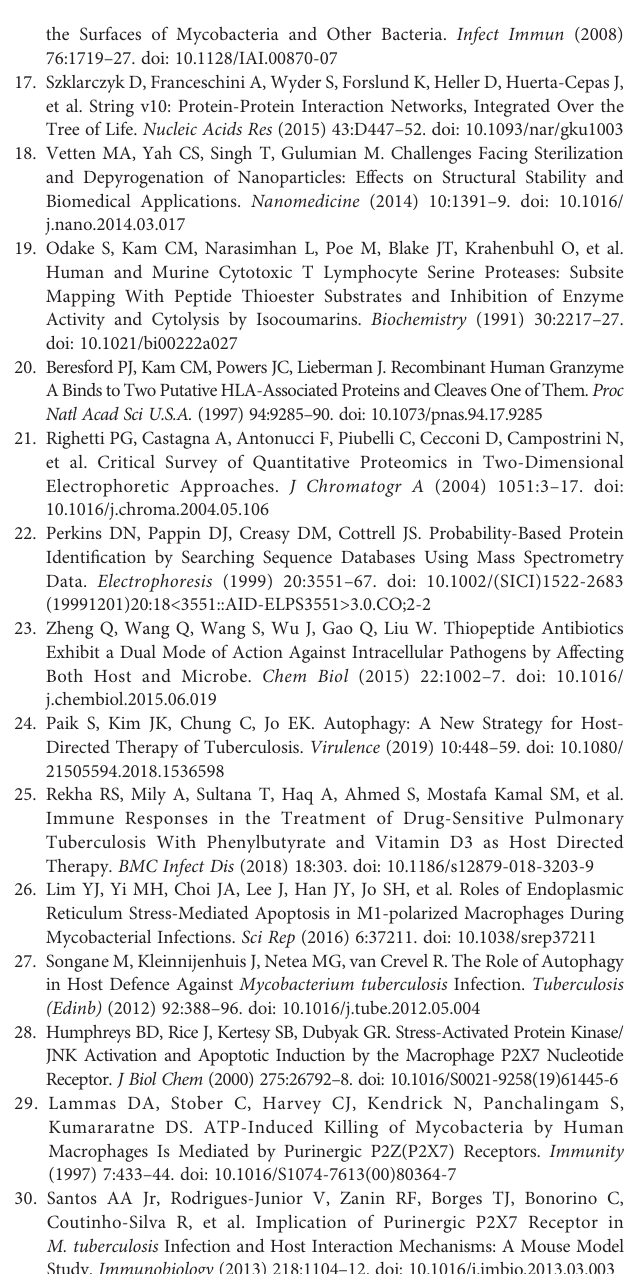
STRING database enriches protein for their relation to each other by known literature reports. Response to ER stress was upregulated when all the 10 proteins were interrogated. Supplementary Figure 5 | STRING-DB enrichment pathways highlights ATP synthesis pathway involved in GzmA-mediated mycobacterial control. STRING with machine-generated additional nodes. Supplementary Figure 6 | Example of BiP protein validated by Odyssey platform (quantitativewesternblot).Ontheleft,proteinwasnormalizedusingtotalproteinstain,while on the right software analyzed signal and validated upregulation in BCG + GzmA